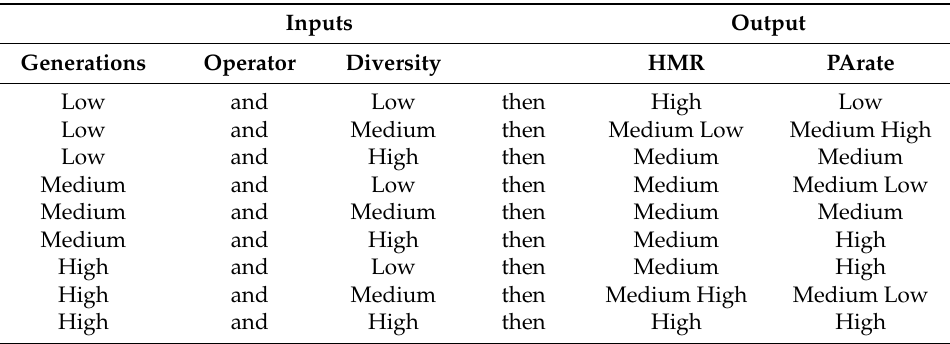
Figure 14. Fuzzy harmony search algorithm. Table 3. Fuzzy rules for the FHS.